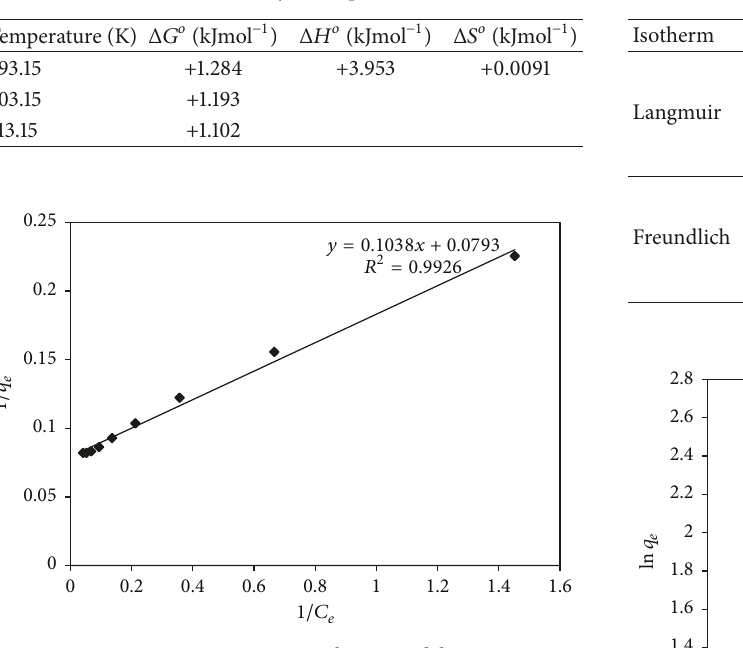
Figure 9: Langmuir isotherm model.